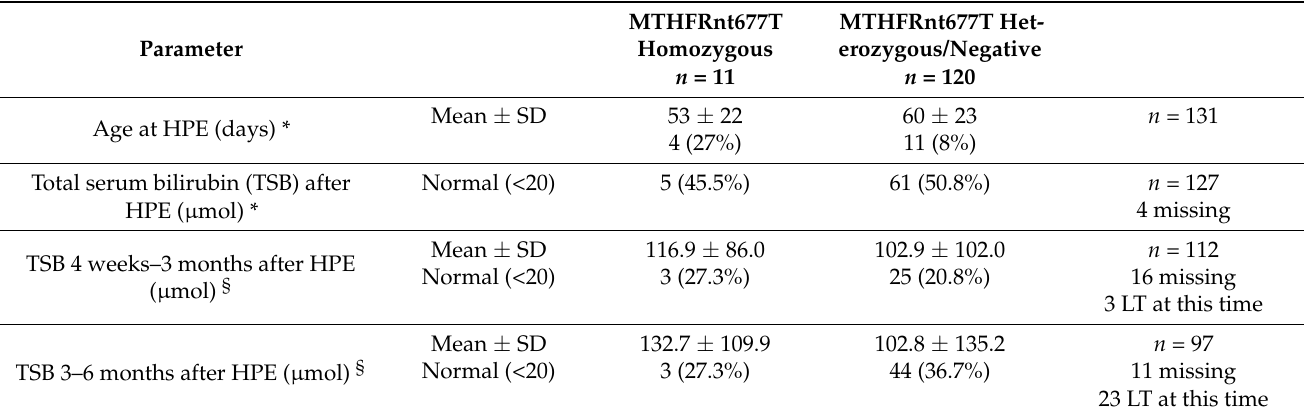
Table 4. Association of homozygous MTHFRnt677TT mutation and normalization/level of TSB after